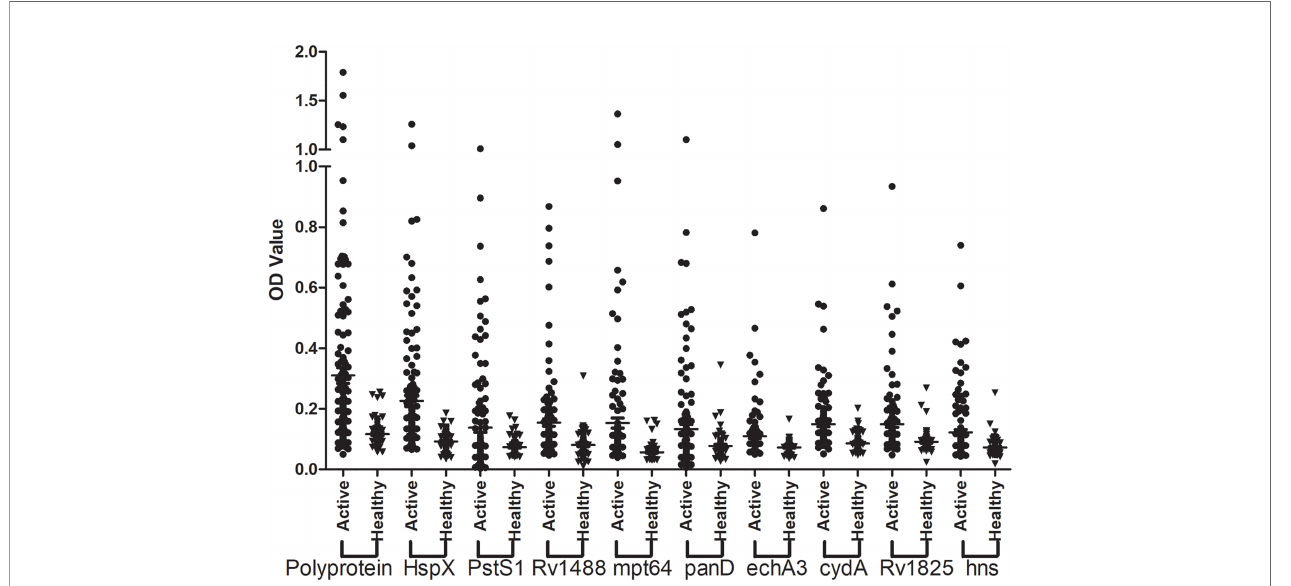
FIGURE 5 | Assessment of the sensitivity and speci fi city of the fusion polyprotein. The indirect ELISA assay was conducted and the sensitivity and speci fi city of the polyprotein and each individual antigen or segments was